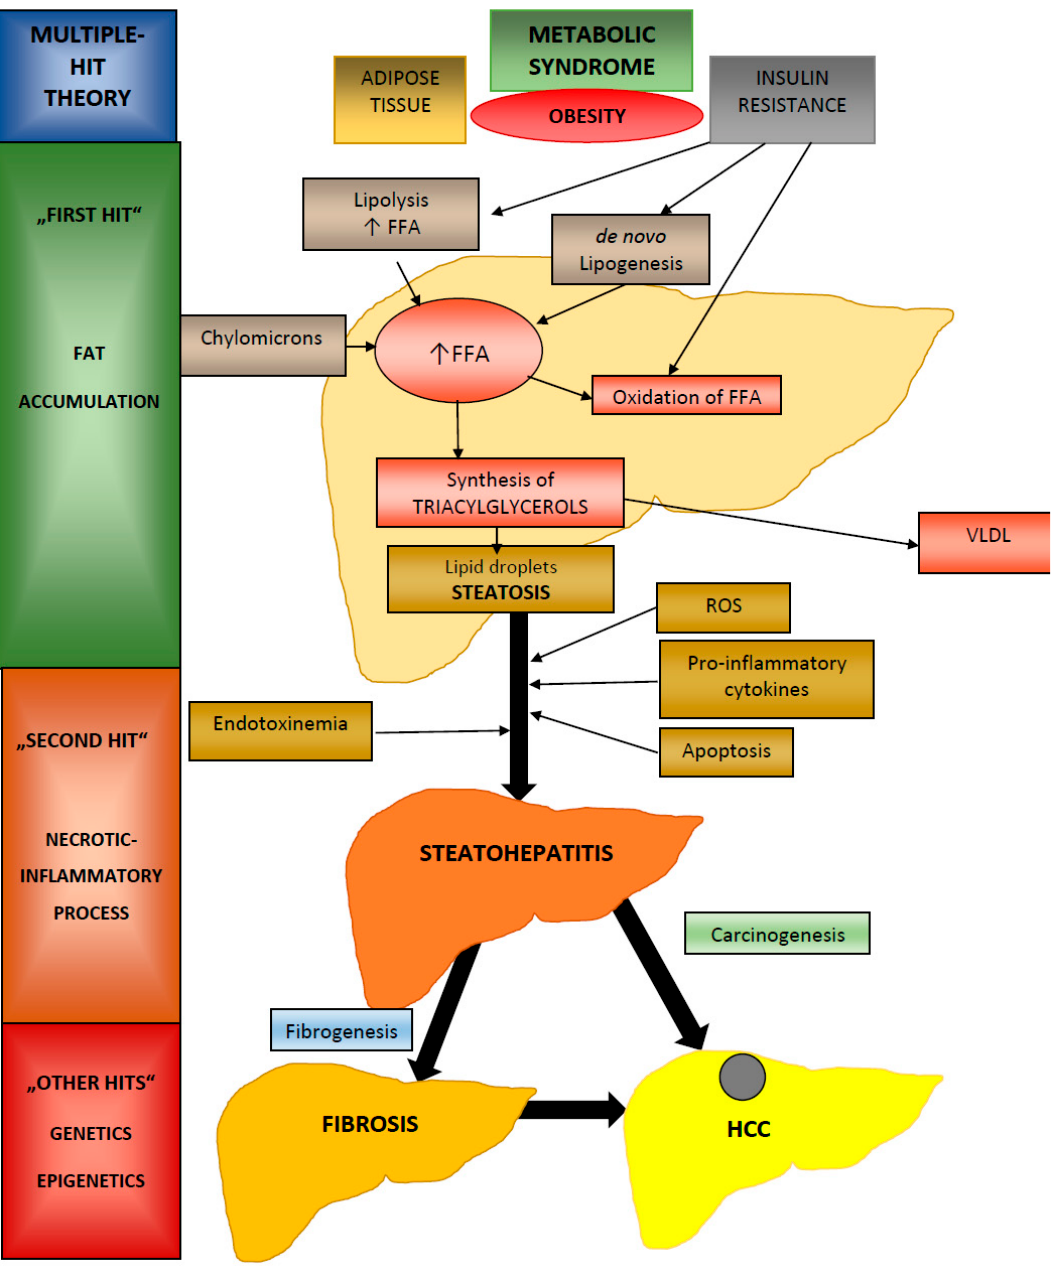
Figure 1. Pathogenesis of nonalcoholic fatty liver disease (NAFLD). Legend: FFA—free fatty acids, VLDL—very low density lipoproteins, ROS—reactive oxygen species, HCC—hepatocellular